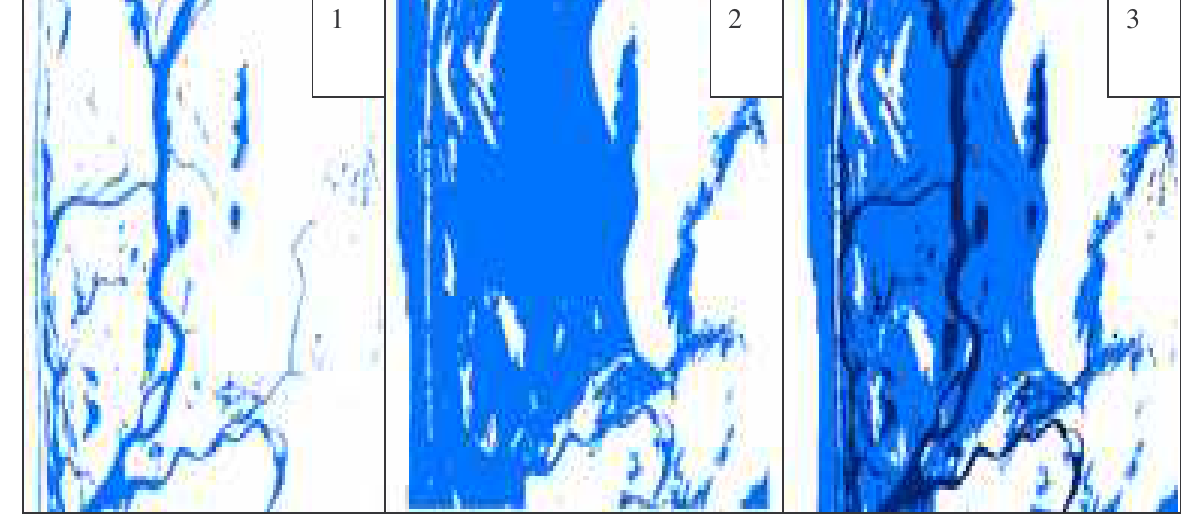
Figure 7: Flood extension in 1999 (1. Normal situation in 2001. 2. Flood situation in 1999, 3. Comparison of the 2